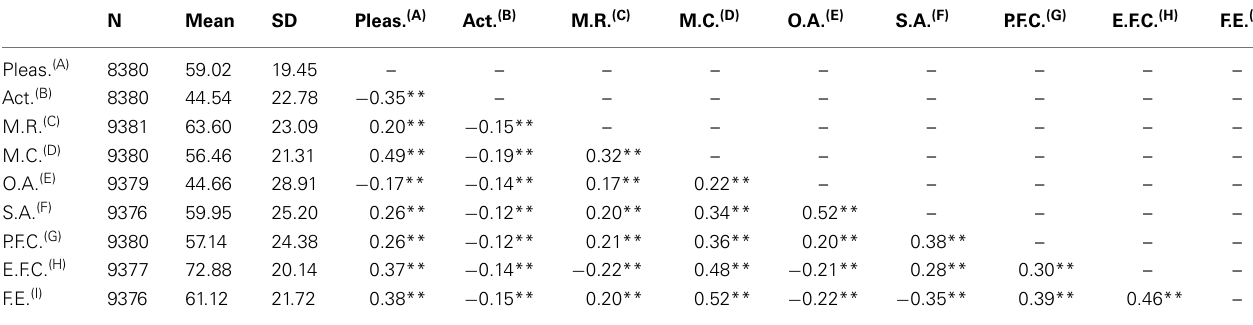
Table 1 | Descriptive statistics and multilevel correlations of core affect and appraisal categories.